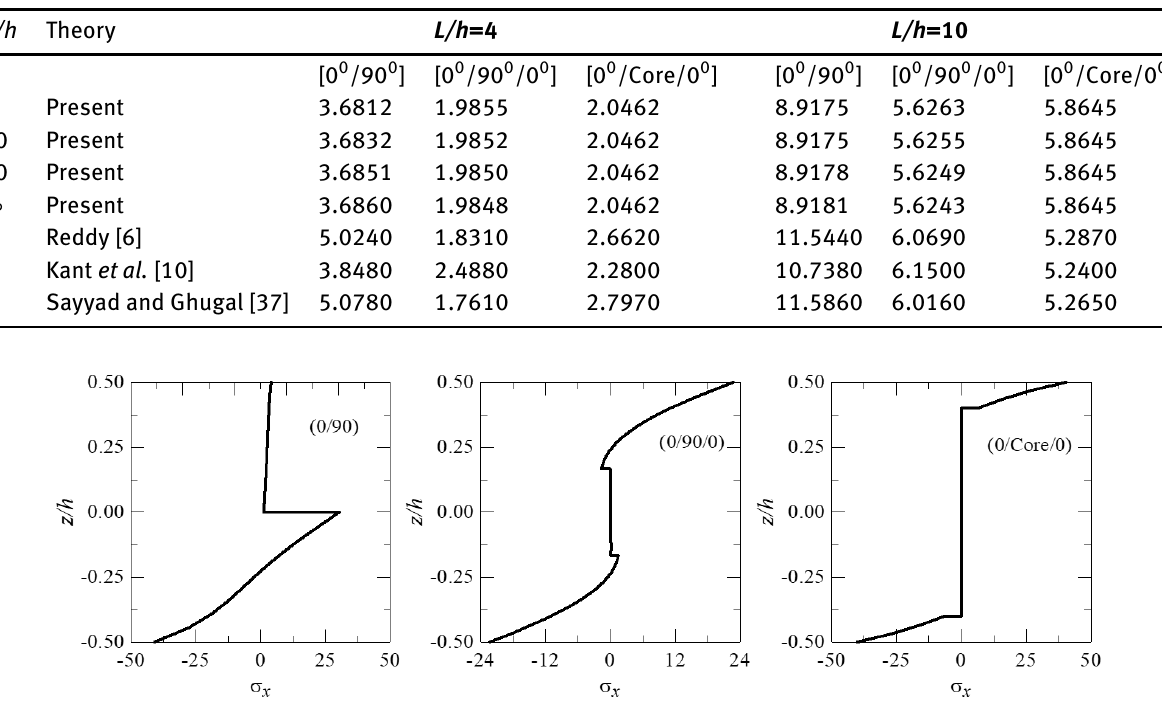
Figure 4: Through-the-thickness variations of bending stresses for laminated and sandwich beams curved in elevation ( L/h= 4, R/h= 5)).